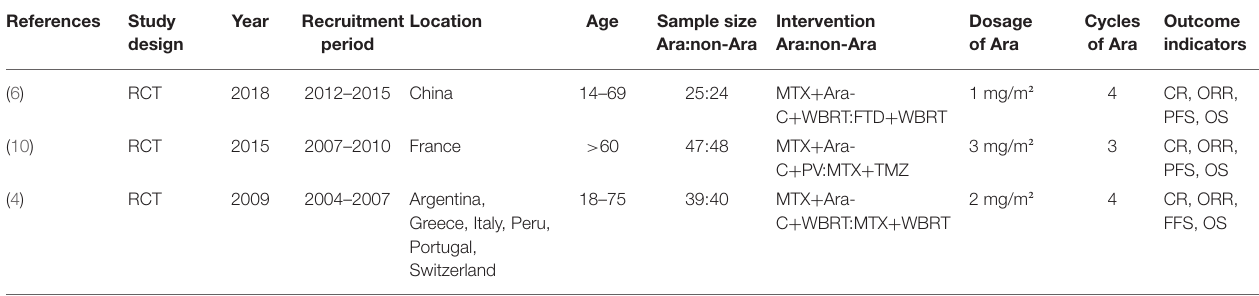
TABLE 1 | Characteristics of enrolled